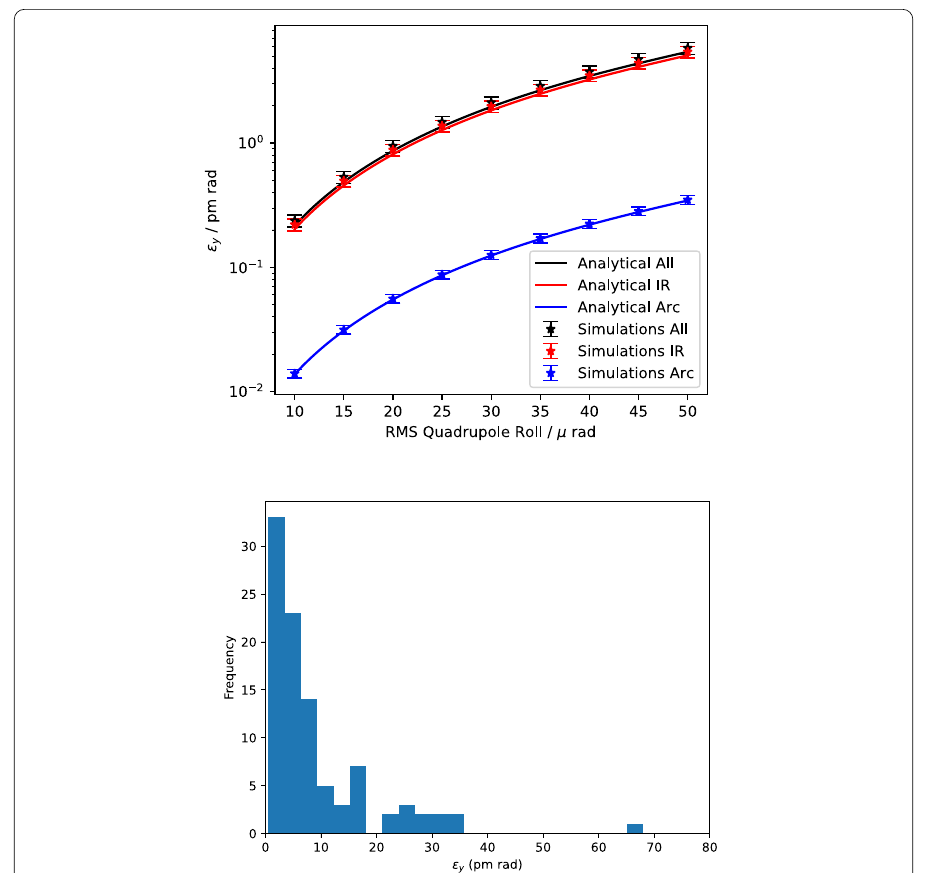
Figure 3 The top plot shows the vertical emittance introduced by quadrupole roll errors. Data points show average emittance from MAD-X simulation with 100 error seeds and the solid lines show the analytical expression. Blue data points and curve represent arc quadrupoles, red represents IR quadrupoles and black represents all quadrupoles. The bottom plot shows a sample distribution of the computed emittance of the 100 error seeds for the case of all quadrupoles rolled with an RMS of 30 μ rad